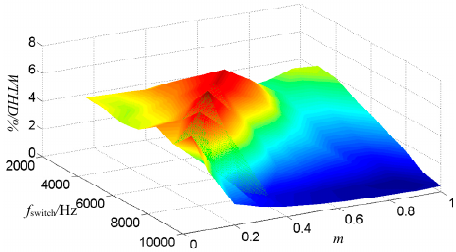
Figure 14. Harmonic characteristic results of WTHD curves of u AB_inv with f switch and m inv .